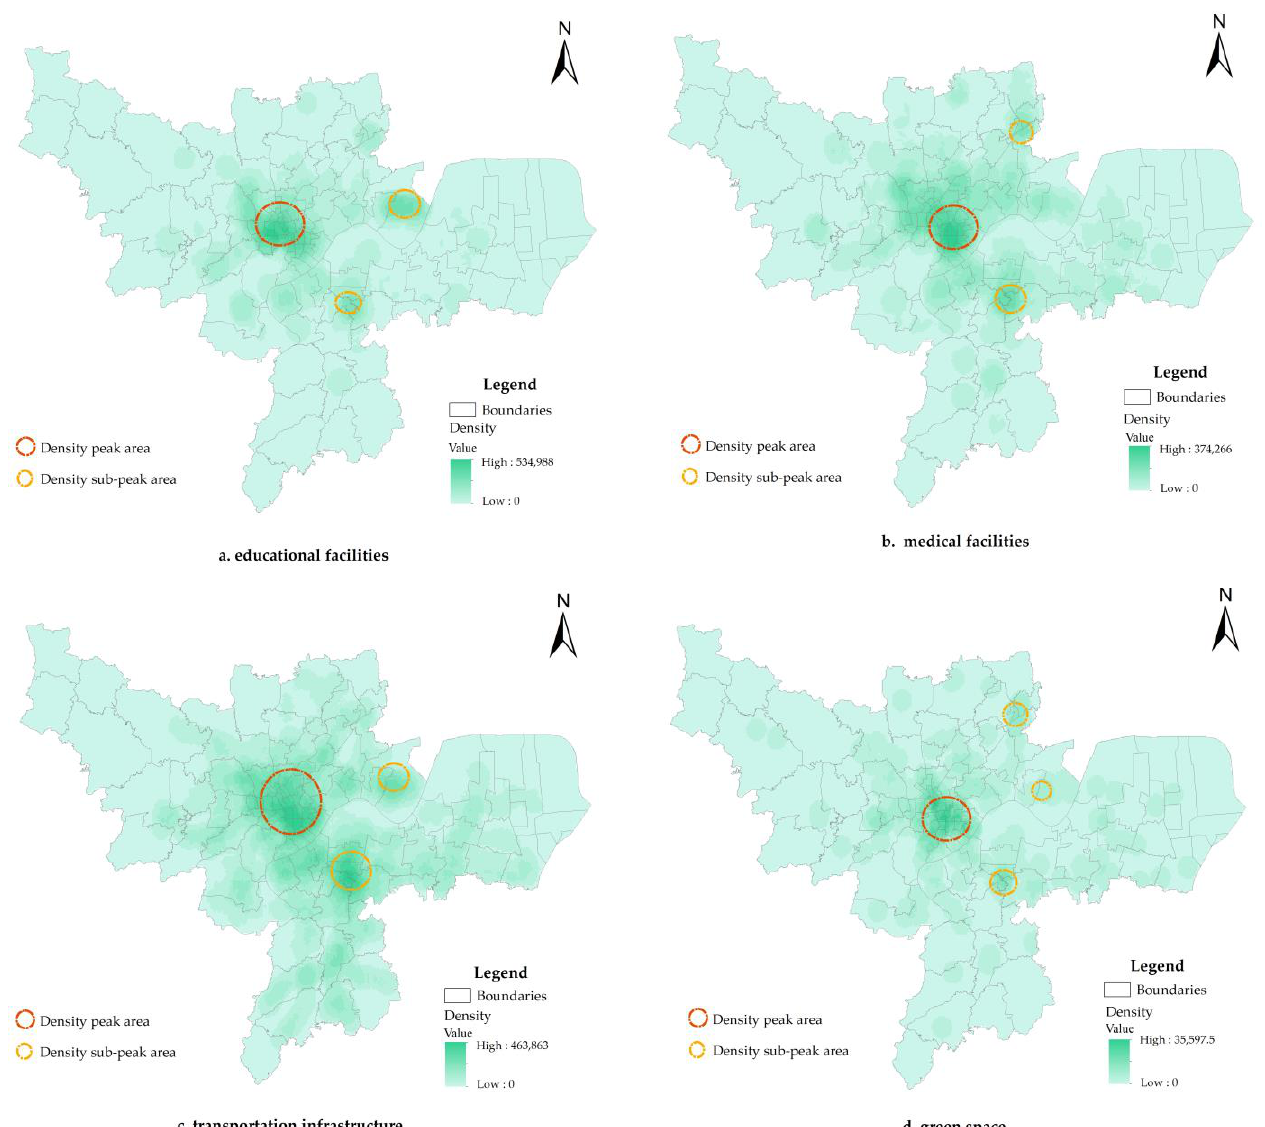
Figure 3. Spatial distribution of the urban internal elements of Hangzhou.